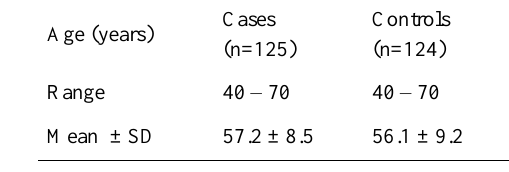
Table 1: Age distribution of study